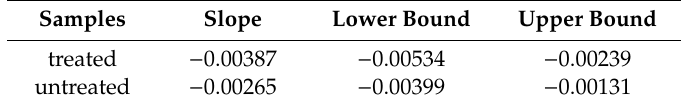
Table 1. Confidence intervals for mass yield correlation coe ffi cient with reaction